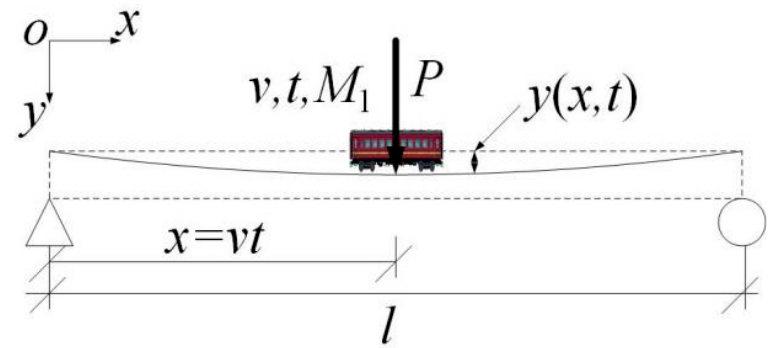
Figure 1. Vehicle–bridge time-varying system.